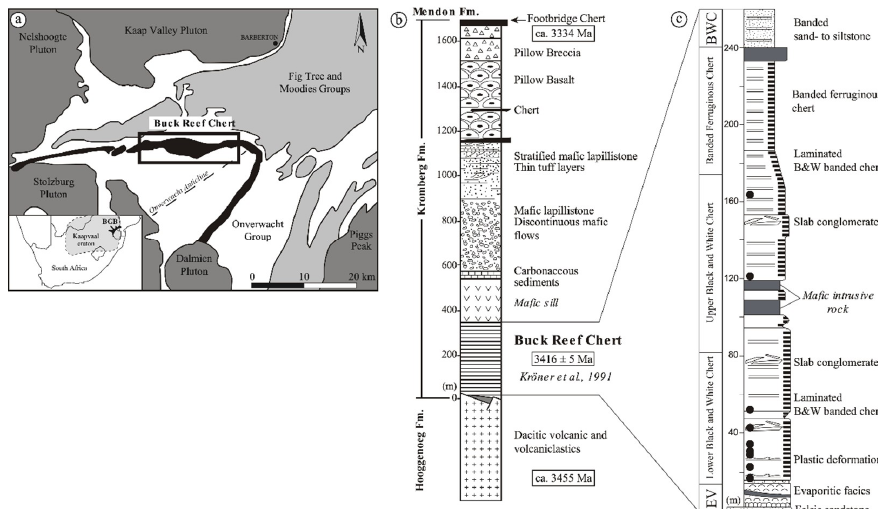
Figure 1. ( a ) Simplified geological map of the Barberton Greenstone Belt, South Africa. Stratigraphy of ( b ) the Hooggenoeg to Kromberg Formation transition and of ( c ) the Buck Reef Chert, modified from Lowe [34] and Tice and Lowe [2], respectively. The Buck Reef sequence is a 250–400 m-thick unit of black and white (B&W) banded cherts overlying dacitic volcaniclastics and volcanic rocks from the Hooggenoeg Fm. The evaporitic to B&W to ferruginous banded chert transition reflects a deepening of the basin [2]. Black circles represent samples location.